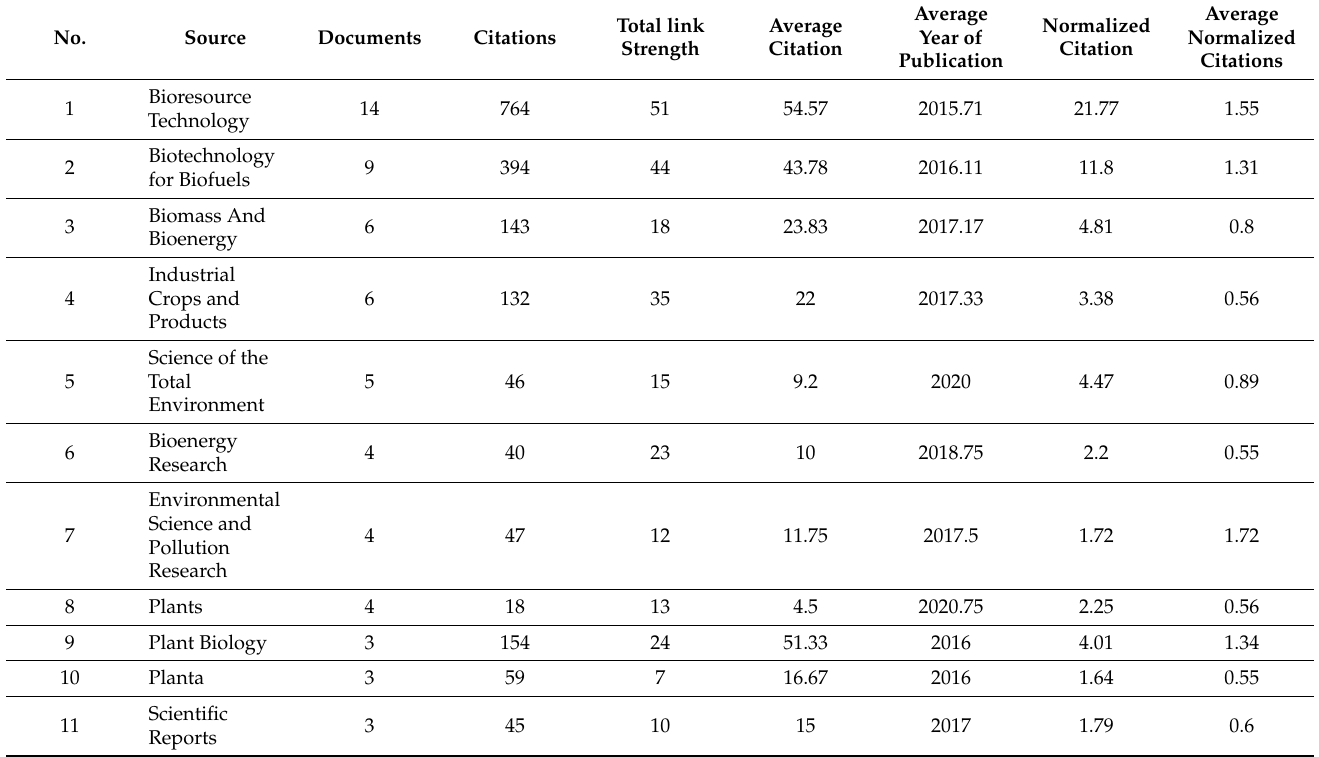
Table 4. Sources with high impacts based on normalized citations.